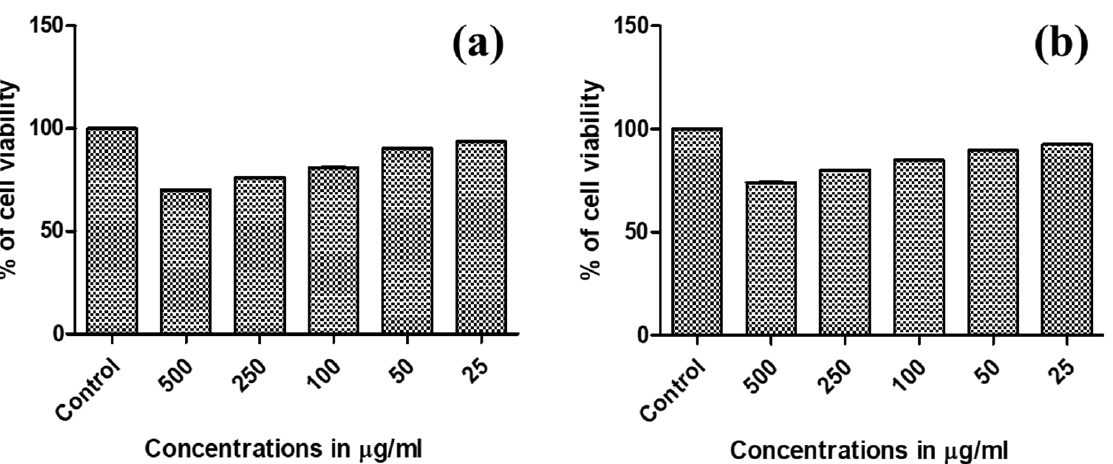
Figure 7. In vitro cytotoxicity effect of green synthesized Ag NPs: ( a ) Cytotoxicity against MCF-7 cells; and ( b ) Cytotoxicity against L-929 ( b ) cells.